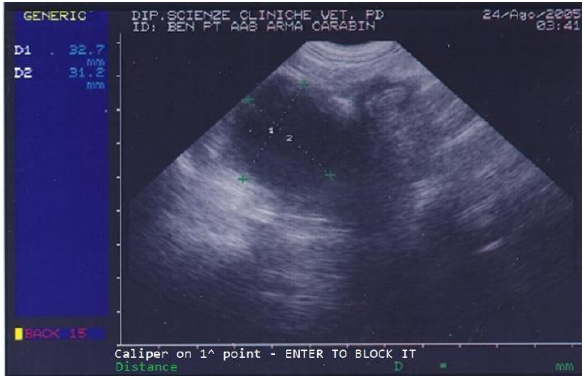
Figure 1. Abdominal ultrasonography of a German shepherd dog before deslorelin implant. The scan shows the ultrasonographic appearance of the prostate. The largest prostatic cysts’ perpendicular diameters are measured as D1 = 32.7 mm and D2 = 31.2 mm.